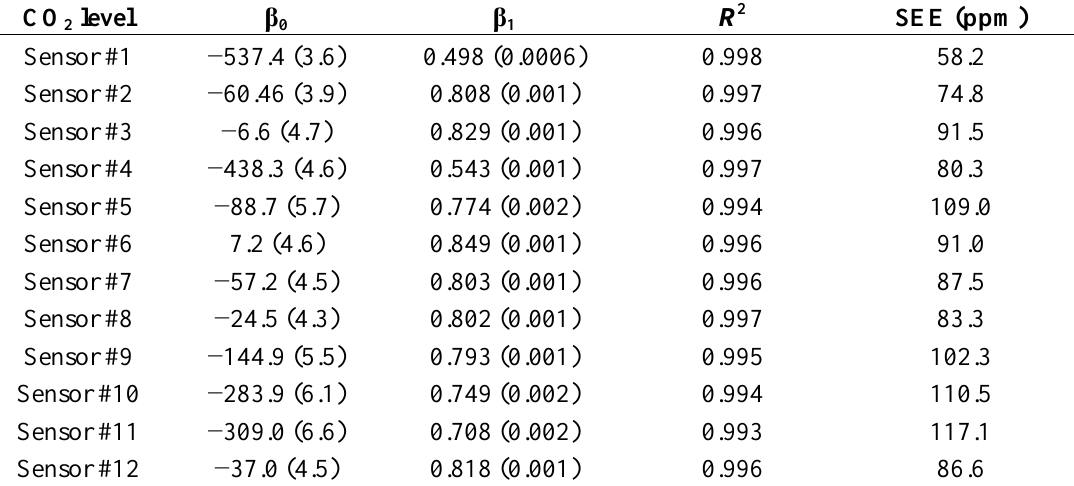
Table 4. Calibration parameters of individual sensors. The calibration model is CO corrected = β + β × CO + ε. Standard errors of coefficients are indicated in 0 1 2 sensor parenthesis. The determination coefficient ( R 2 ) and the standard error of estimation (SEE) are also